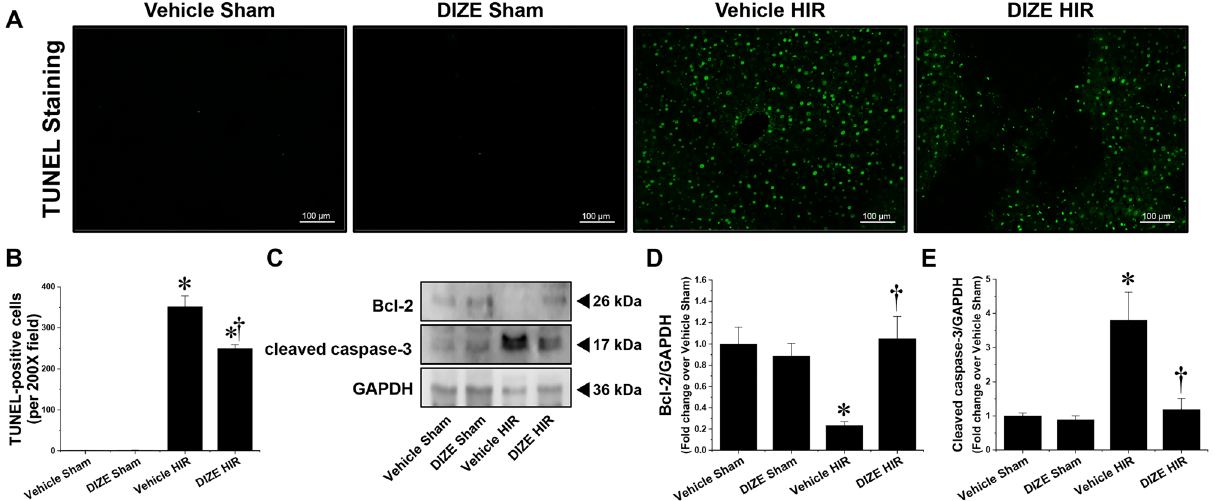
Figure 2. Effect of DIZE on apoptosis following hepatic ischemia/reperfusion. C57BL/6 male mice were subjected to partial hepatic ischemia (HIR) induction for 1 h or sham surgery. Mice were treated with either Diminazene aceturate (DIZE) or vehicle control (saline) before undergoing surgery, as described in “Methods”. Twenty-four hours after surgery, liver sections were subjected to TUNEL staining ( A ; magnification X200) and the TUNEL-positive cells were counted ( B ). ( C ) Whole liver lysates were subjected to western blotting using B-cell lymphoma 2 (Bcl-2) and cleaved caspase-3 antibodies. GAPDH was used as a loading control. ( D, E ) Band intensities were measured using the ImageJ v.1.53e software. Results are expressed as mean ± SEM (n = 5). For statistical analysis, one-way ANOVA with plus Tukey’s post hoc multiple comparison test were used to detect significant changes with Origin 2021 v.9.8.0 200 (OriginLab, https:// www. origi nlab. com) software. *P < 0.05 vs. Vehicle Sham, †P < 0.05 vs. Vehicle